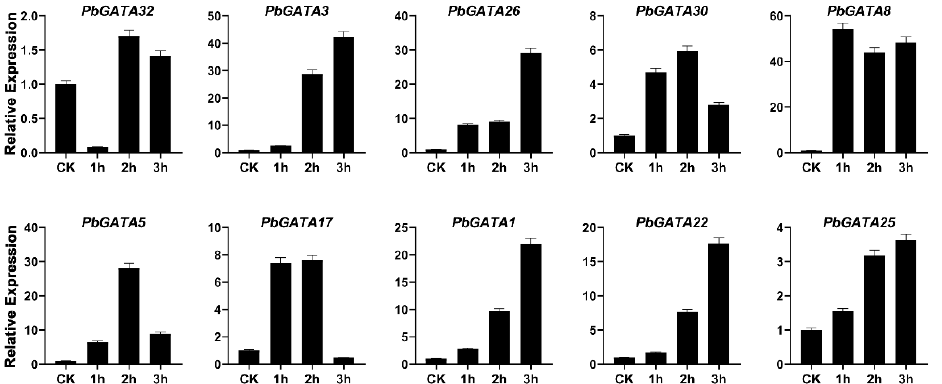
Figure 12. Expression profiling of GATA gene family analyzed by qRT-PCR in the fruit of Chinese pear at the developmental stage after hormonal treatment of salicylic acid (SA) and CK represents control. Error bars represent the standard error (SE) of three biological replicates.